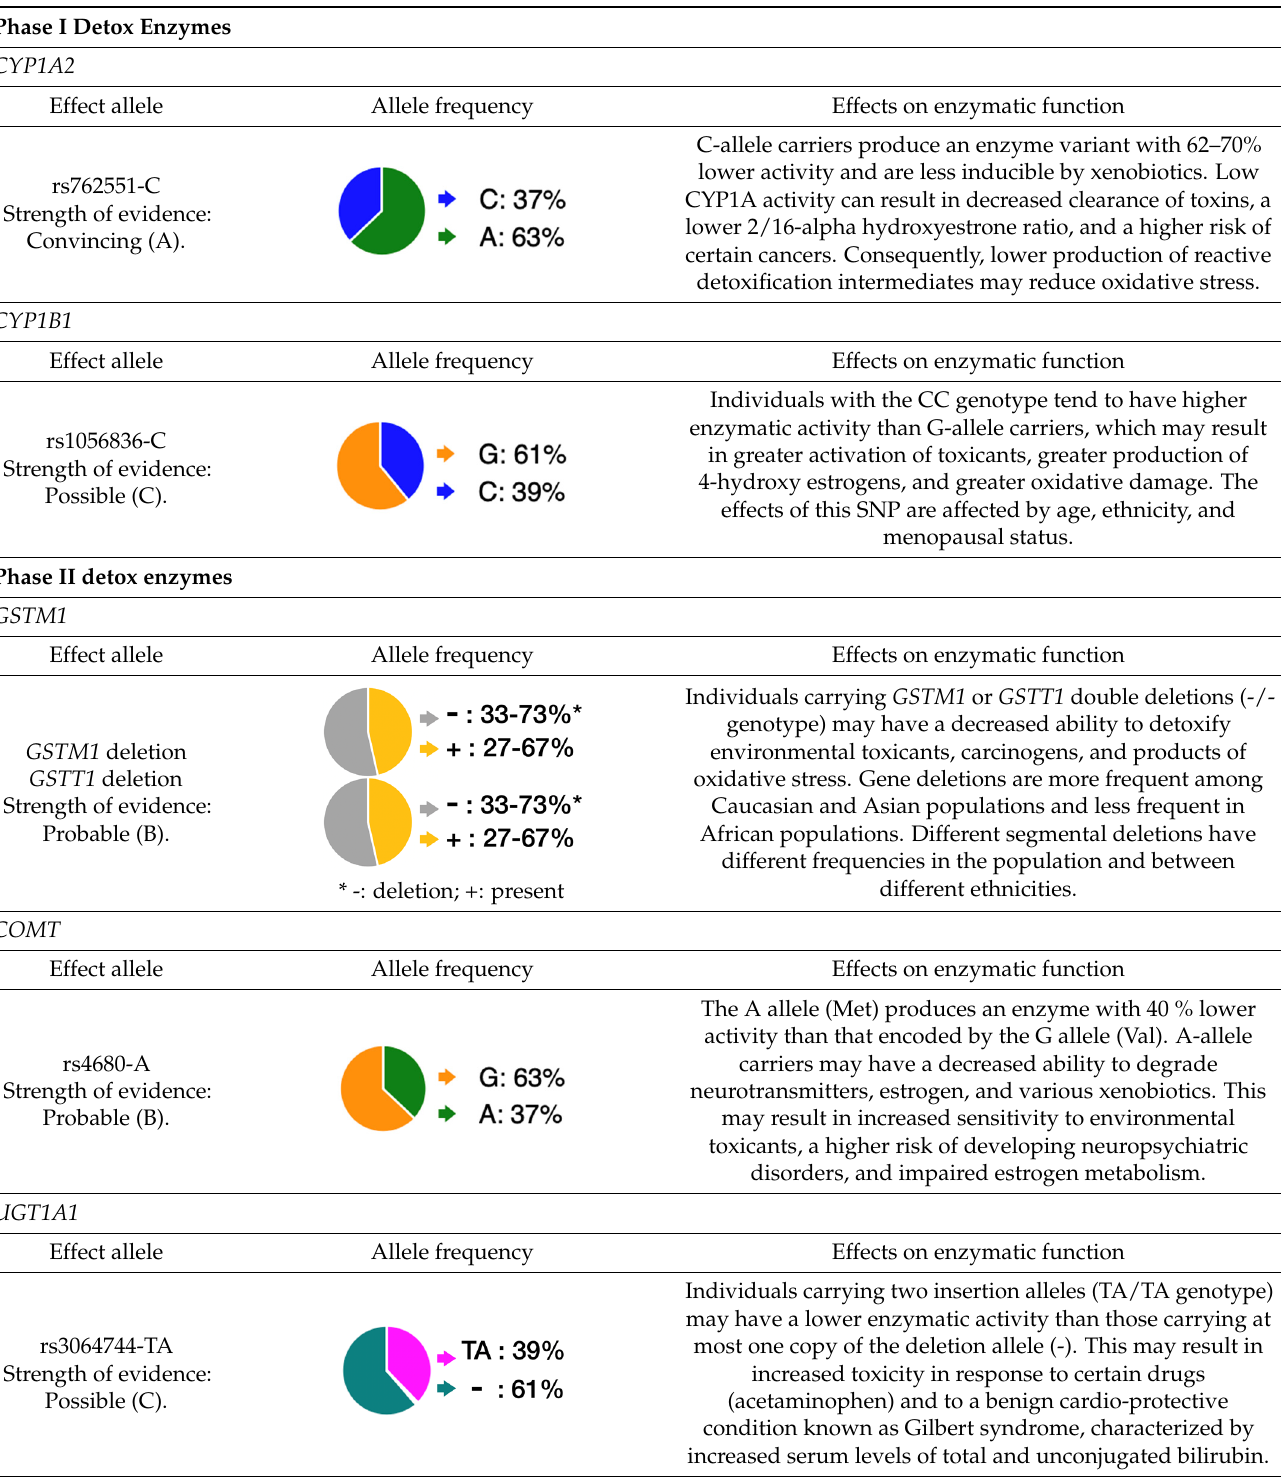
Table 2. Foods and nutrients that modulate the activity of Phase I/Phase II enzymes and their inter- action with genotype. Food/Nutrient